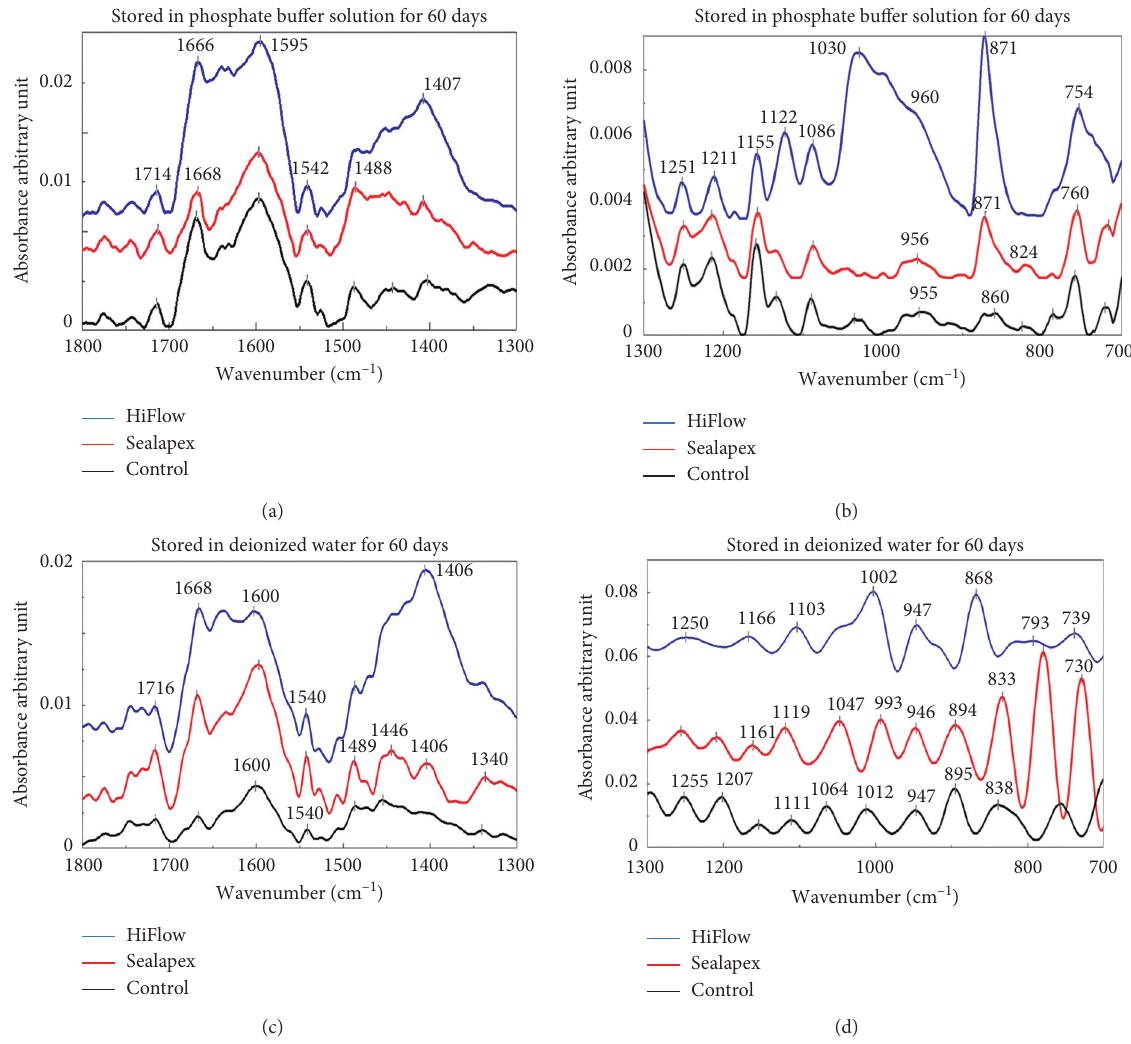
Figure 1: Fourier transform infrared spectra of the dentin samples: the spectra of HiFlow-treated dentin, either stored in phosphate buffer solution (a and b) or deionized water (c and d) for 60 days, showed some changes in intensity and/or shift of amide I v carbonate bands (at 1720–1580 and 1200–900 and 890–830cm − 1 , respectively) compared with untreated dentin. No obvious change was observed in spectra of Sealapex-treated